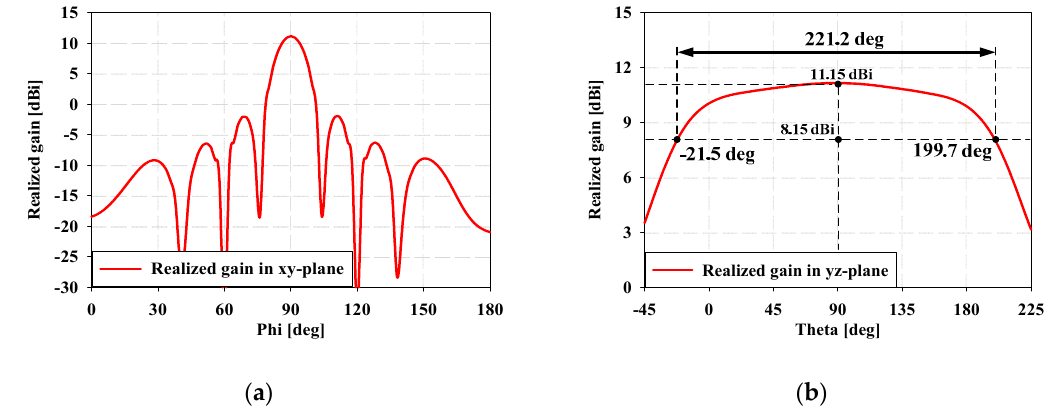
Figure 10. Radiation pattern of the proposed phased array antenna at 28 GHz when the phase difference between element ports is 0 degree (0 degree scan): ( a ) XY plane ( b ) YZ plane.